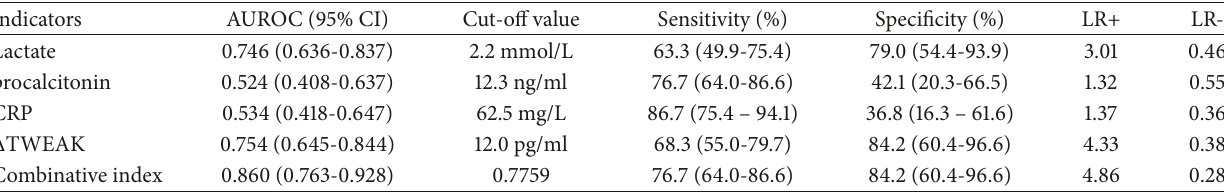
Table 2: Diagnostic performances of 3 routine biomarkers (lactate, NT-proBNP and CRP), Δ TWEAK and combinative index ( Δ TWEAK concentrations and lactate) for prognosis of patients with sepsis.